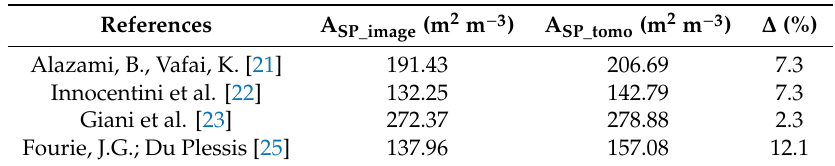
Table 4. Summary of the calculated specific surface area of metal foam sample according to the used